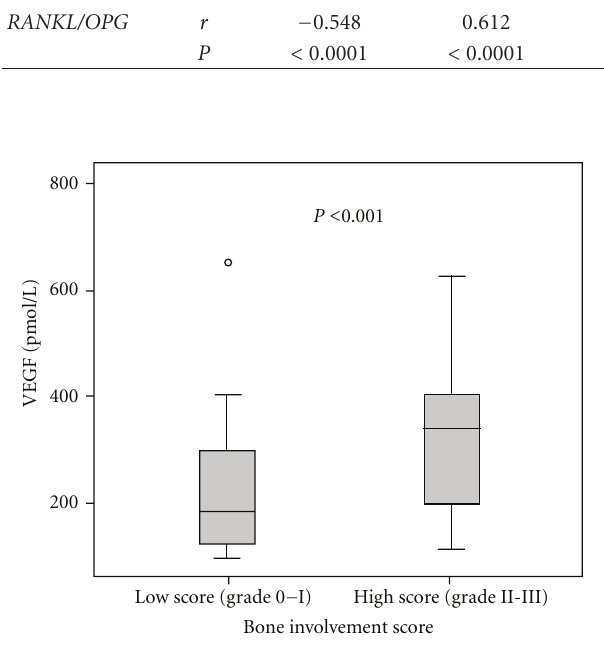
Figure 3: Serum VEGF levels according to bone involvement